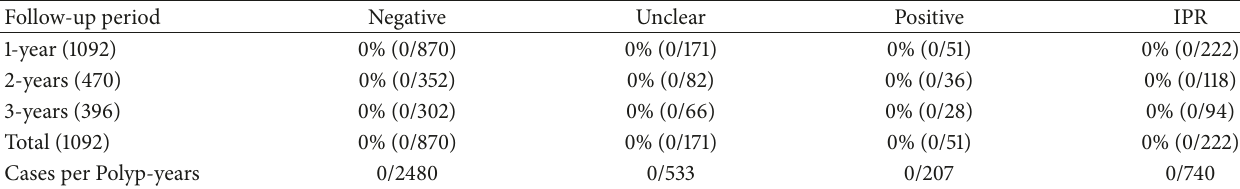
Table 2: The incidence density of local recurrence for each margin